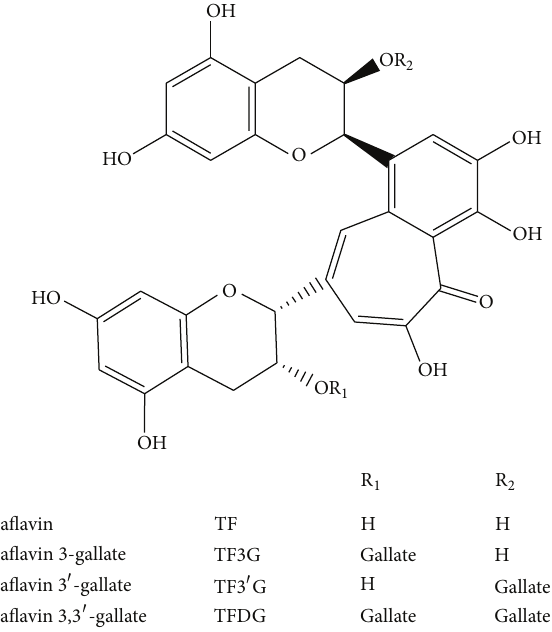
Figure 1: Polyphenols of black